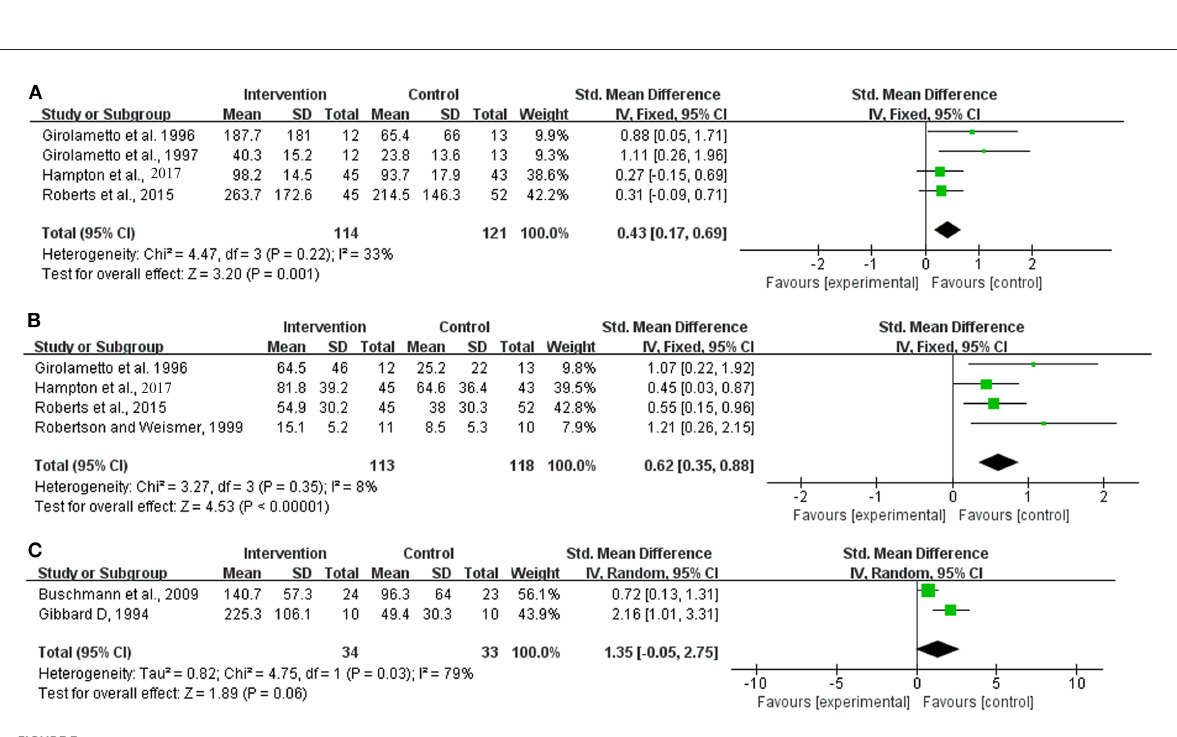
FIGURE3 Meta-analysis outcome of the intervention effect on expressive vocabulary development. (A) Overall vocabulary development; (B) Different words used in a language sample; (C) Parent reports of vocabulary. Control, no or delayed treatment.